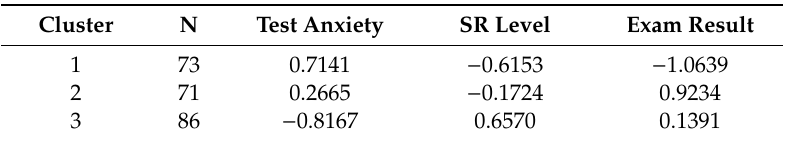
Table 4. Mean values of anxiety, self-regulation, and USE result in the distinguished clusters (standardized